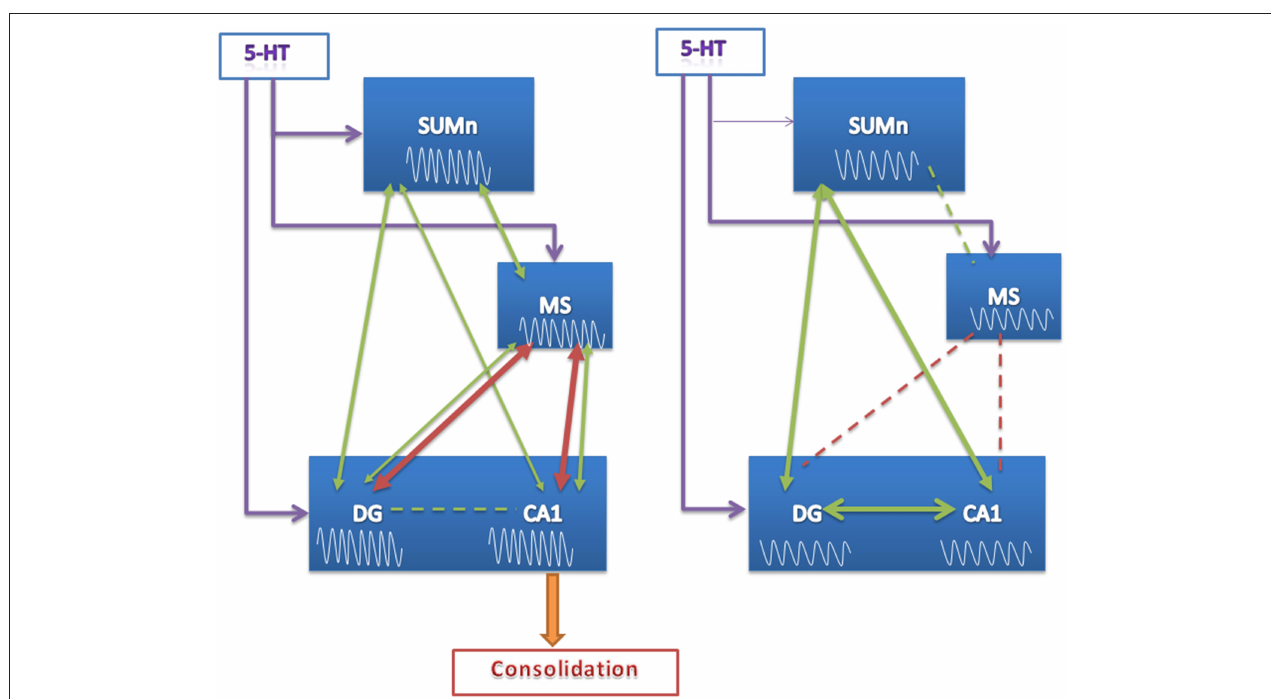
FIGURE 10 | Proposed model of function of the SUMn, the MS and the hippocampus circuit during learning after SUMn serotonin-depletion. The model represents the results observed principally the last days of training. EEG RP values are represented into the boxes, showing that no increase in high frequency RP was observed in the EXP group. Green arrows represent values of frequency peak; red arrows represent values of coherence. The thickness of the arrows represent the grade of coherence or correlation; broken lines represent the lack of coherence or correlation. When 5-HT was reduced in the SUMn, the circuit appear to entrain into a closed mode between SUMn and hippocampus. The lack of communication between MS and CA1 would impair the consolidation of